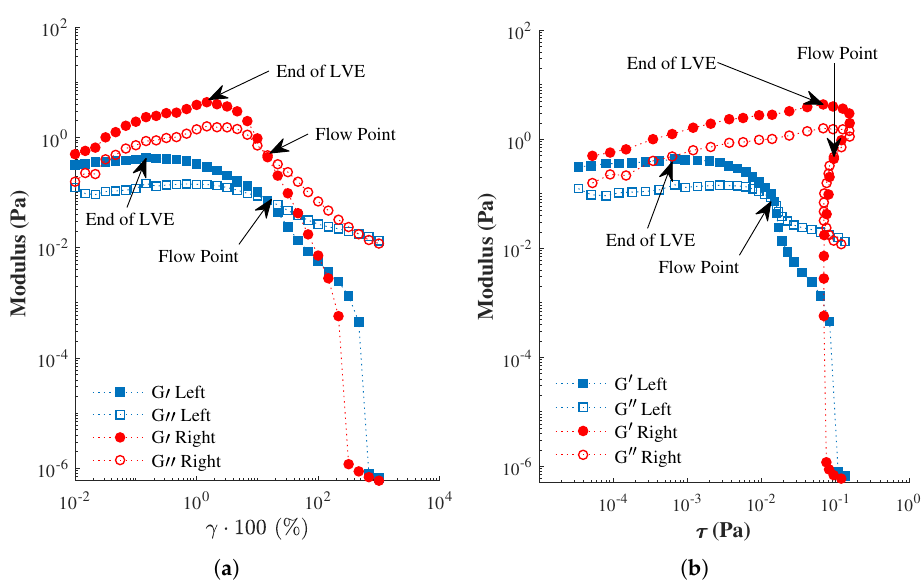
Figure 3. The viscoelastic behavior of human milk represented by milk from Participant #6. ( a ) The deformation at the limit of LVE, γ y , and crossover of G (cid:48) and G (cid:48)(cid:48) . ( b ) The corresponding shear stress required for yield and flow of human milk.